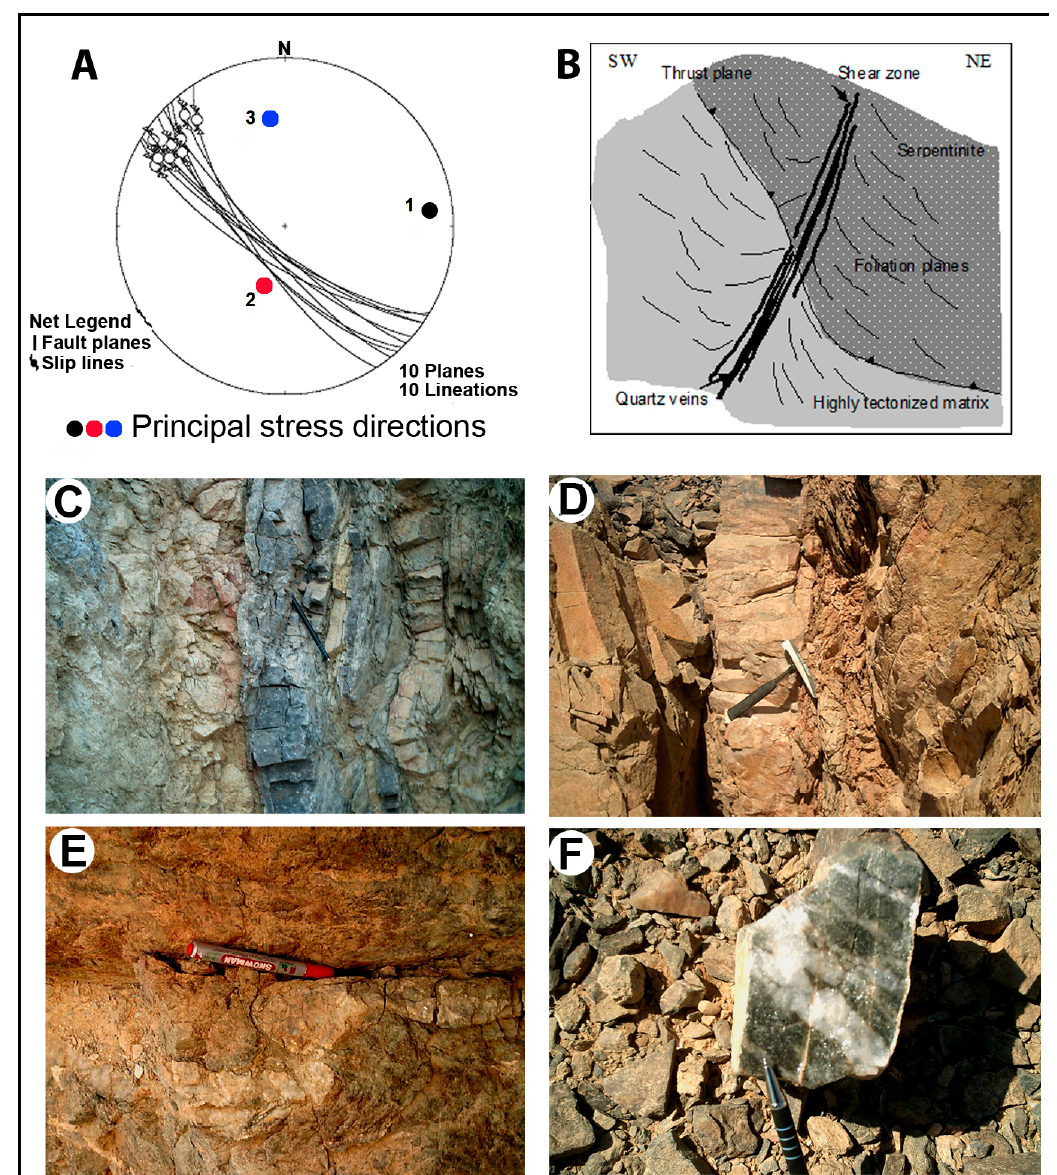
Figure 14. ( A ) Equal area stereographic projection (lower hemisphere) of planes of the shear zone and poles to the associated slickensides; ( B ) sketch drawing explaining the geometrical relationship between the quartz veined shear zone in the Hutit mine and the thrust structures. Note the deflection of the foliation about the shear zone (based on field observations); ( C ) nearly vertical, bluish-gray quartz veins associated with highly sheared serpentinite in the northern mine (looking NW); ( D ) milky quartz vein cutting metavolcanic rocks in the southern mine (looking N); ( E ) S-shaped quartz vein indicating a sinistral sense of shearing (looking W); ( F ) grayish quartz vein traversed by milky veinlets. The sample is from the northern mine lode.